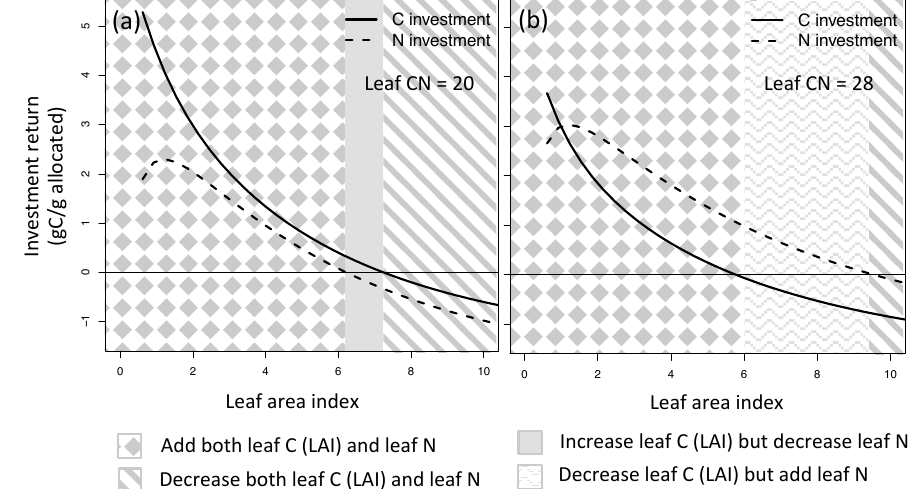
Figure 3. A schematic illustrating the simultaneous adjustment of leaf area index (LAI) and leaf C : N (see legend above) based on the C return on marginal investment of leaf C (solid line) and leaf N (dashed line). Panel (a) shows the situation with a leaf C : N of 20 and (b) shows the situation with a leaf C : N of 28, as examples. An optimal LAI and leaf N emerges from adjusting allocation so that marginal investment returns are zero for both leaf C and